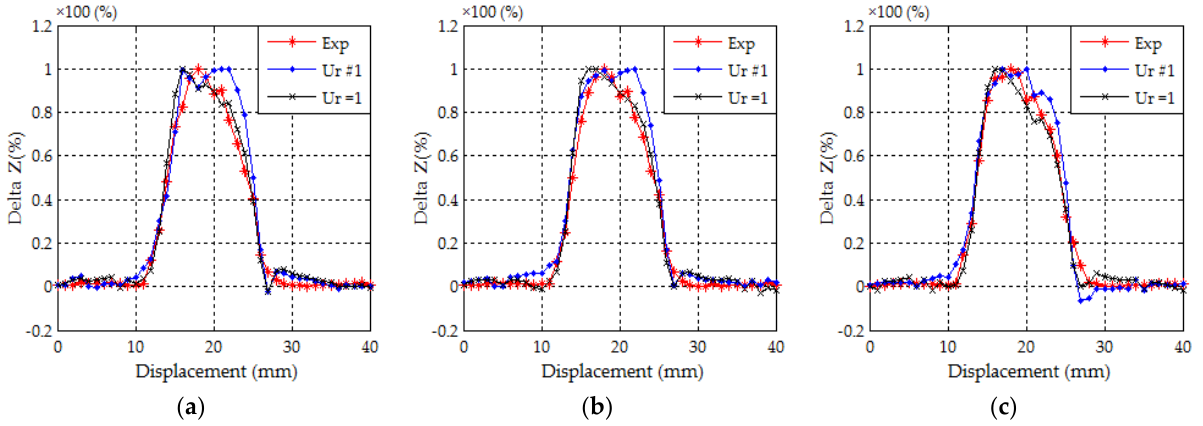
Figure 10. Impedance variation in (%) at 40 kHz with ( a ) depth = 0.3 mm, ( b ) depth = 0.5 mm, and ( c ) depth = 1 mm.